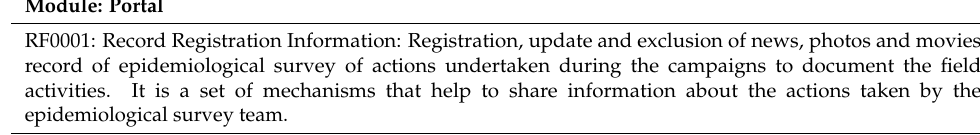
Table 1. Modules functional